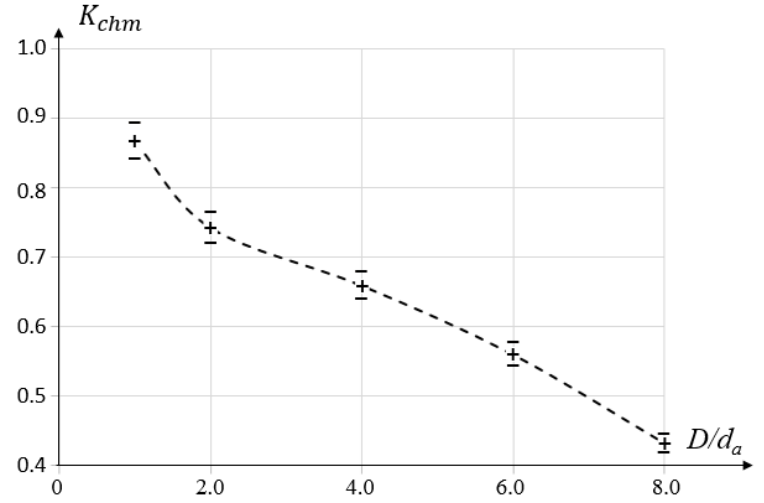
Figure 13. Mixture homogeneity coe ffi cient K chm vs. parameter D / d a (experimental Figure 13. Mixture homogeneity coefficient 𝐾 (cid:3030)(cid:3035)(cid:3040) vs. parameter D / d a (experimental data). Figure 13. Mixture homogeneity coefficient 𝐾 (cid:3030)(cid:3035)(cid:3040) vs. parameter D / d a (experimental data).